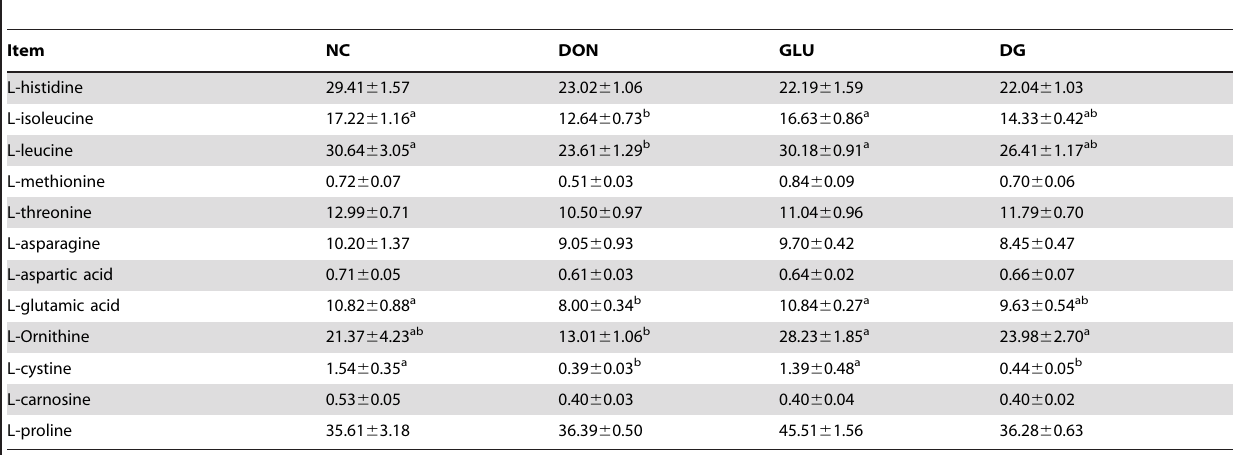
Table 5. Effect of dietary supplementation with glutmic acid on serum amino acids levels ( m g/ml) in piglets fed a deoxynivalenol- contaminated diet on day 30.